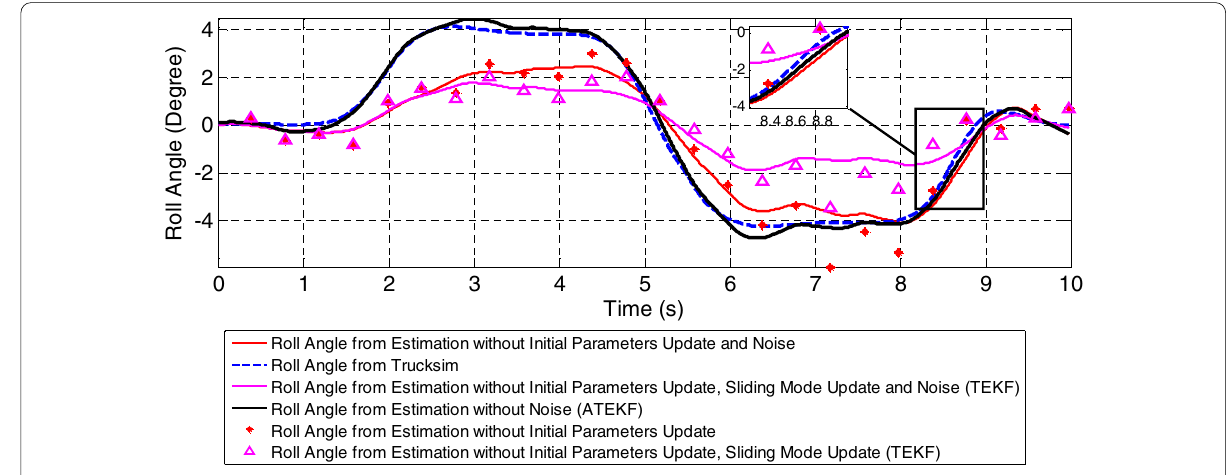
Figure 13 Comparisons between ATEKF and TEKF under Condition